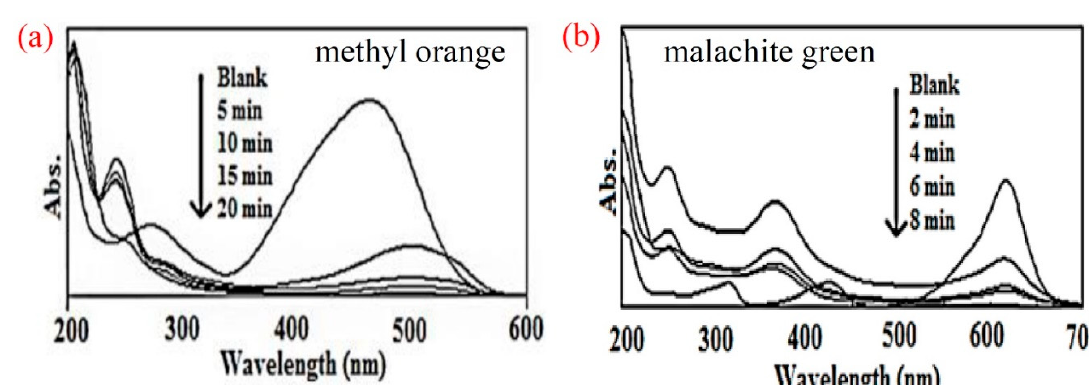
Figure 6. UV-Visible spectra of ( a ) methyl orange and ( b ) malachite green after exposure to UV irradiation in different periods of time [43].